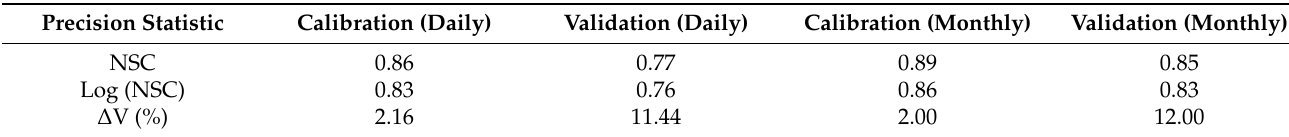
Table 3. Precision statistics for the calibration and validation of the LASH model to the GRB-Furnas basin. NSC, Nash– Sutcliffe coefficient.